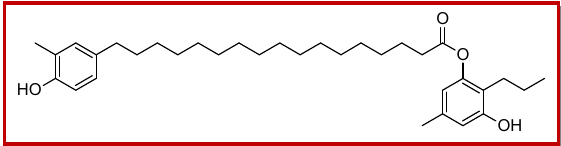
Figure 2: Structure of resorcinol type lipid isolated from C.cupreum